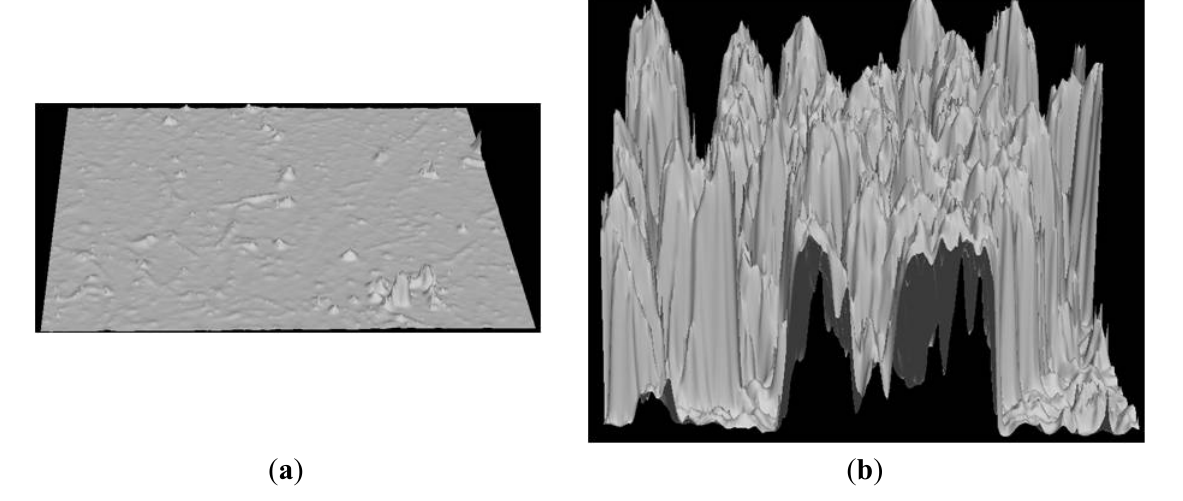
Figure 3. Canopy Height Model (CHM) representing (a) CHM-Plot C20 Clearcut